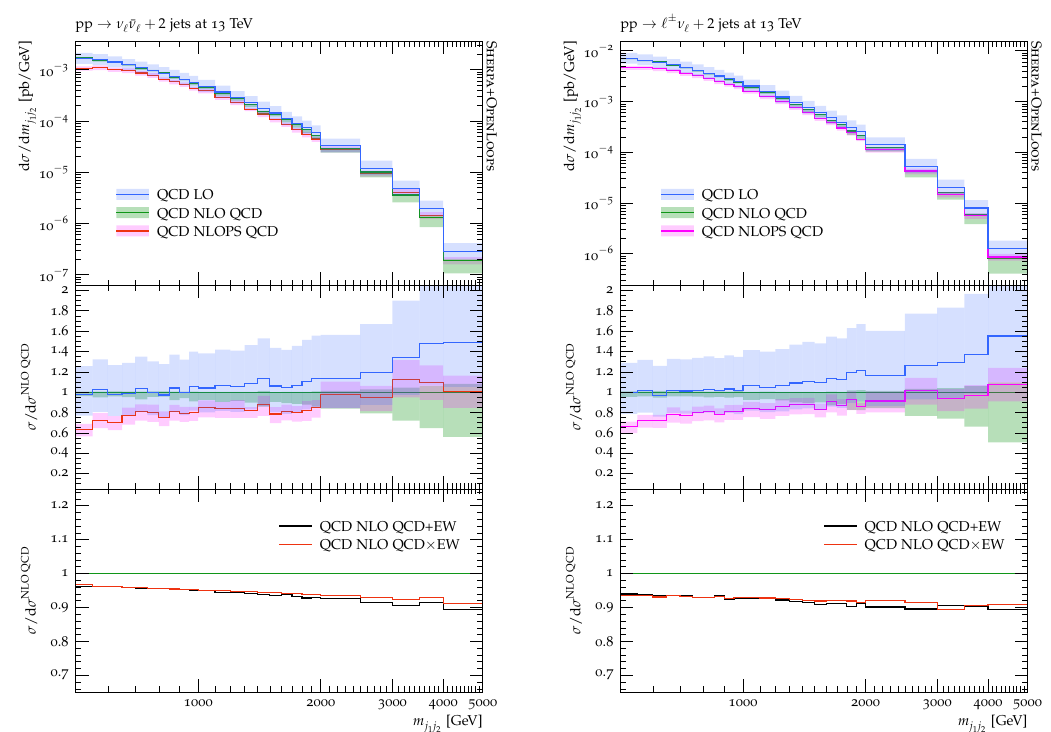
Figure 4. Distribution in the invariant mass of the two hardest jets, m j Z ( ν ‘ ¯ ν ‘ ) + 2 jets (left) and QCD pp → W ± ( ‘ ± ν ‘ ) + 2 jets (right). The upper frame displays absolute LO QCD (blue), NLO QCD (green), and NLO+PS QCD (magenta) predictions, and ratios with respect to NLO QCD are presented in the central panel. The bands correspond to QCD scale variations, and in the case of ratios only the numerator is varied. The lower panel shows the relative impact of NLO QCD+EW (black) and NLO QCD × EW (red) predictions normalised to NLO